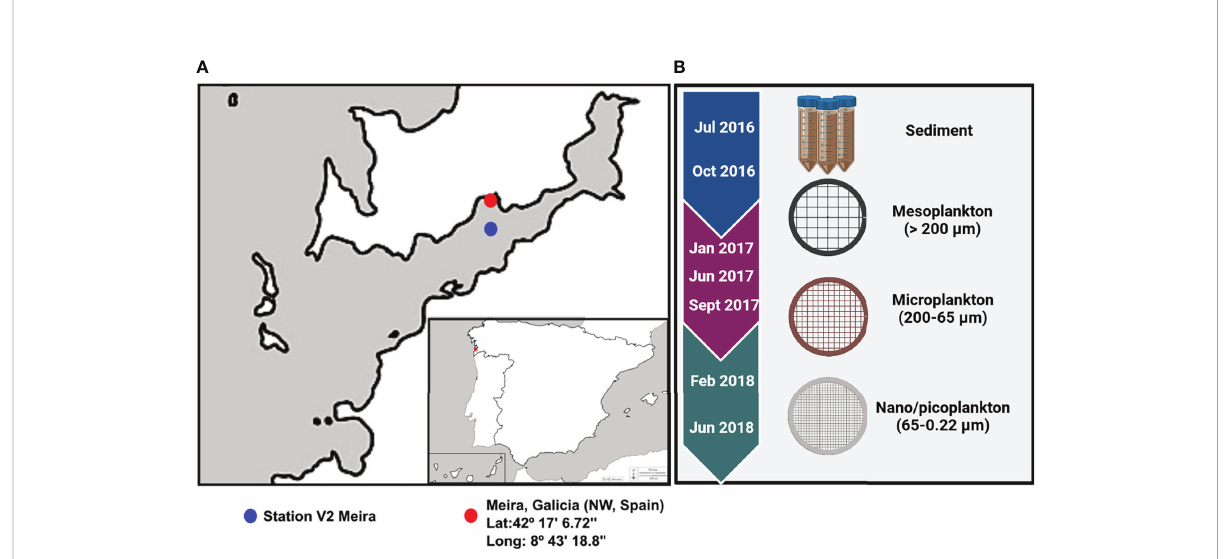
FIGURE 1 (A) Location of the bivalve production area in R ı ́ a of Vigo (Meira, NW Spain) and location of Station V2 where environmental parameters were obtained. (B) The sampling period extended from 2016 to 2018, and environmental samples collected for analysis were